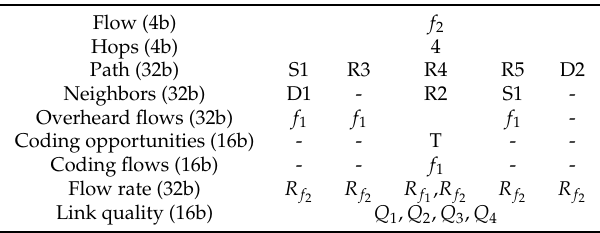
Table 3. The routing information stored in the RREP